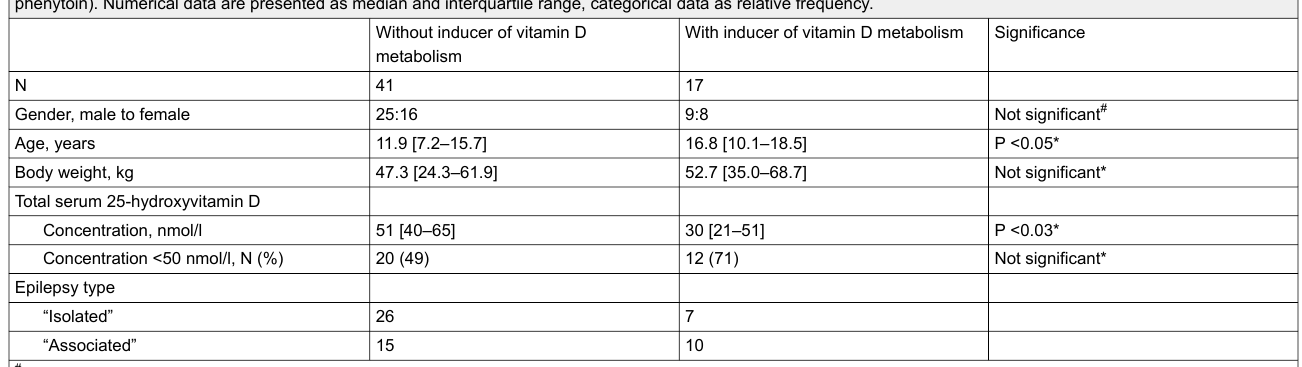
Table 2: Clinical data in 41 epileptic patients without and 17 with drugs that induce the metabolism of vitamin D (carbamazepine, oxcarbazepine, phenobarbital or phenytoin). Numerical data are presented as median and interquartile range, categorical data as relative frequency. Without inducer of vitamin D With inducer of vitamin D metabolism